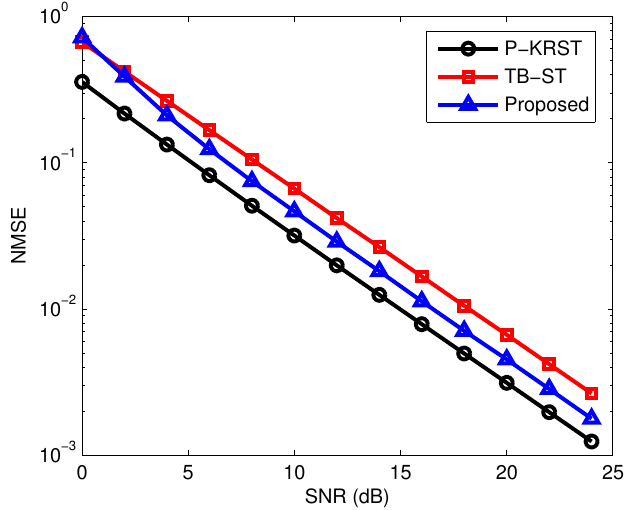
Figure 4. Normalized mean square error (NMSE) performance of different receivers versus SNR.